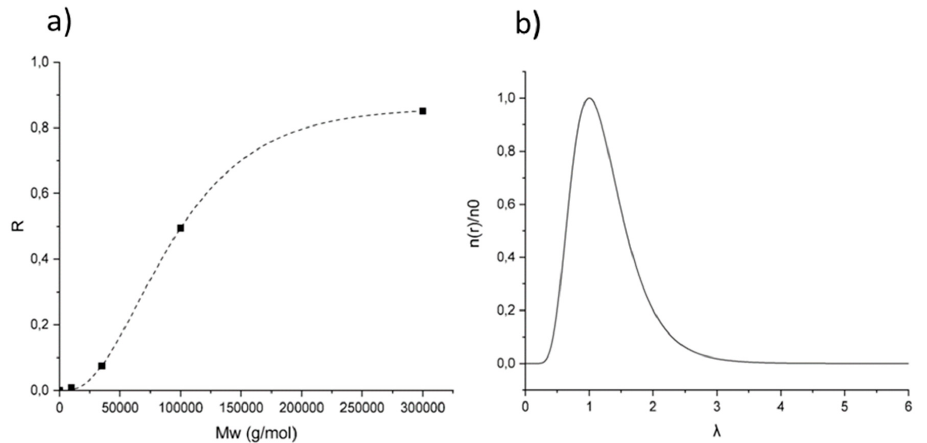
Figure 7. ( a ) Polyethylene glycol (PEG) rejection curve: rejection coefficient (R) vs. the molecular weight of PEG. ( b ) Log-normal pore size distribution: reduced number of pores per unit of area n(r)/n 0 vs. λ , the ratio of solute radius to pore radius.